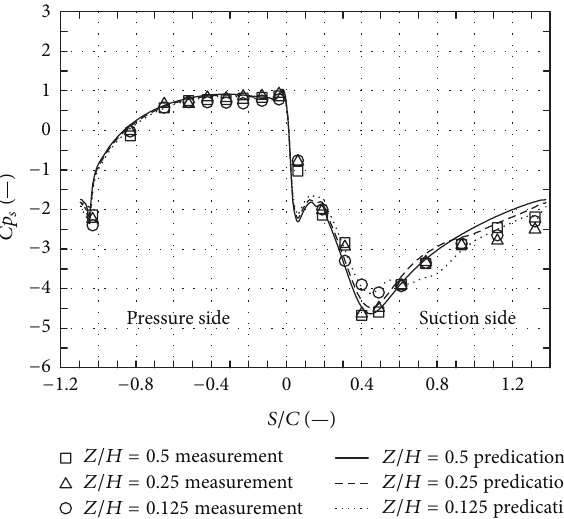
Figure 7: Heat transfer coefficients for different meshes.